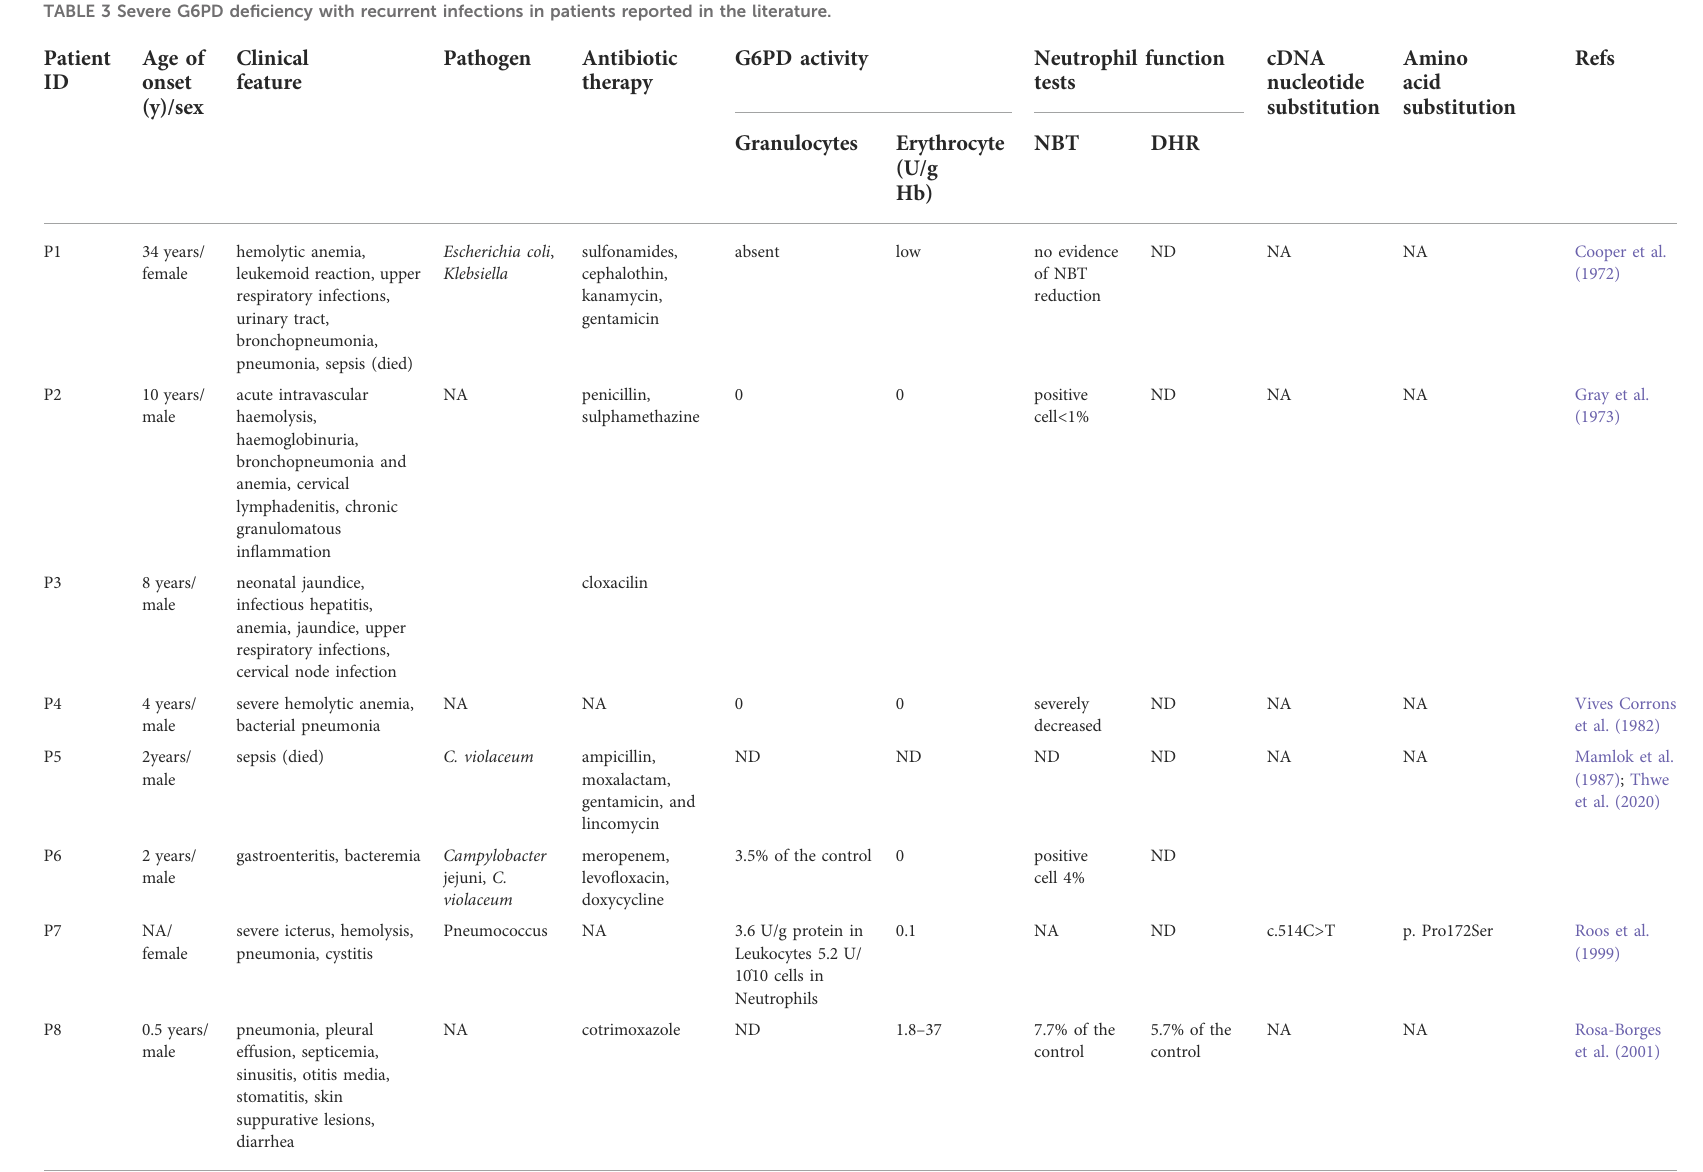
TABLE 3 Severe G6PD de fi ciency with recurrent infections in patients reported in the